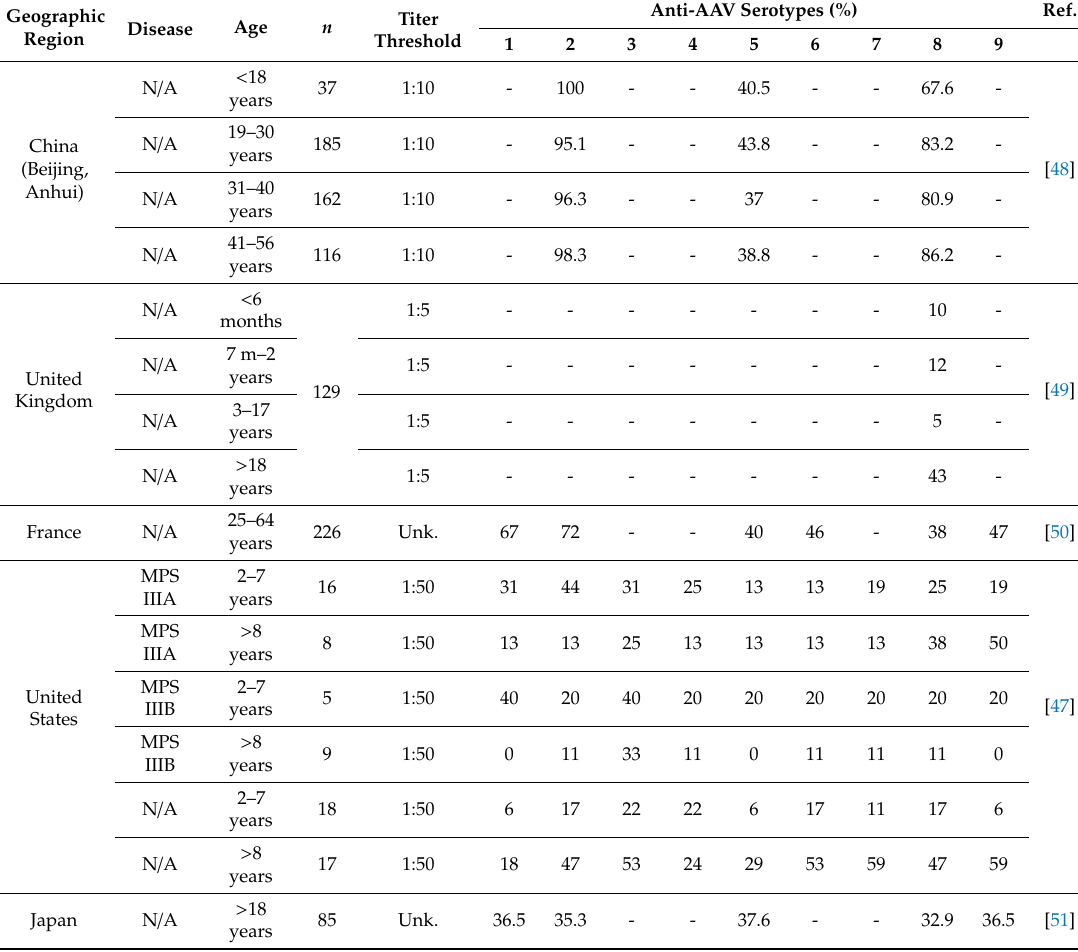
Table 2. Seroprevalence studies among the human population in varying ages, geographic regions, diseases, and serotypes [47–51]. All studies are comprised of male and female